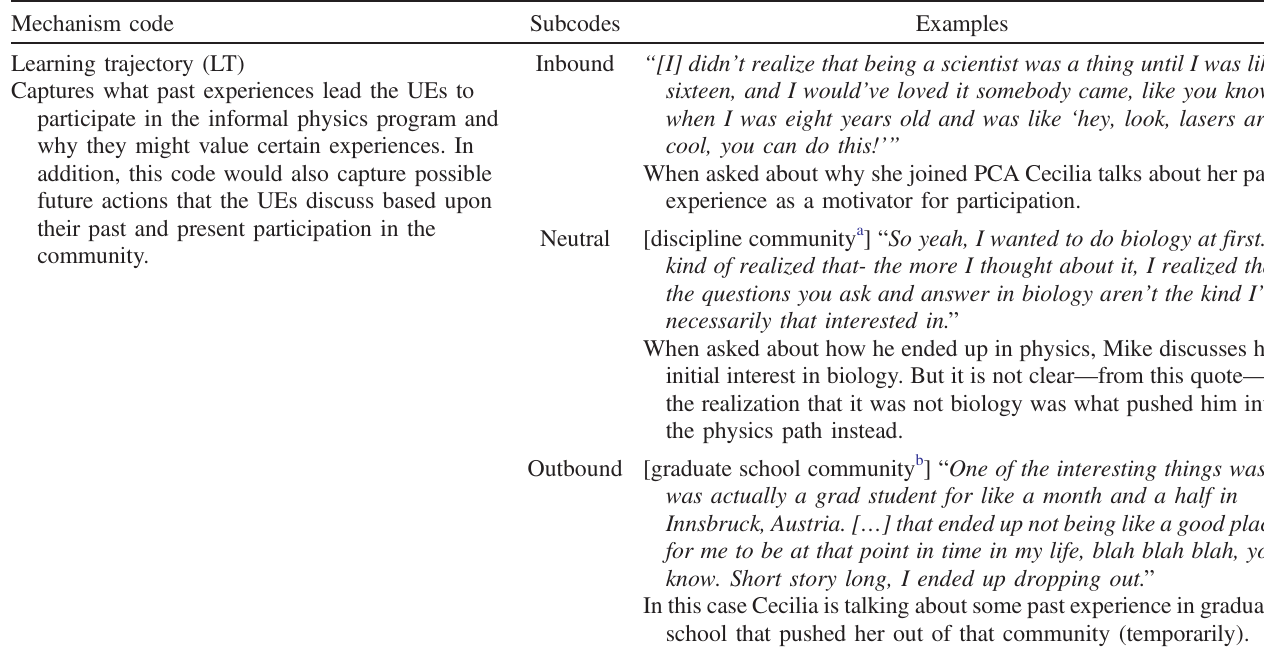
TABLE VII. Examples and explanations for each subcode under the learning trajectory construct. Mechanism